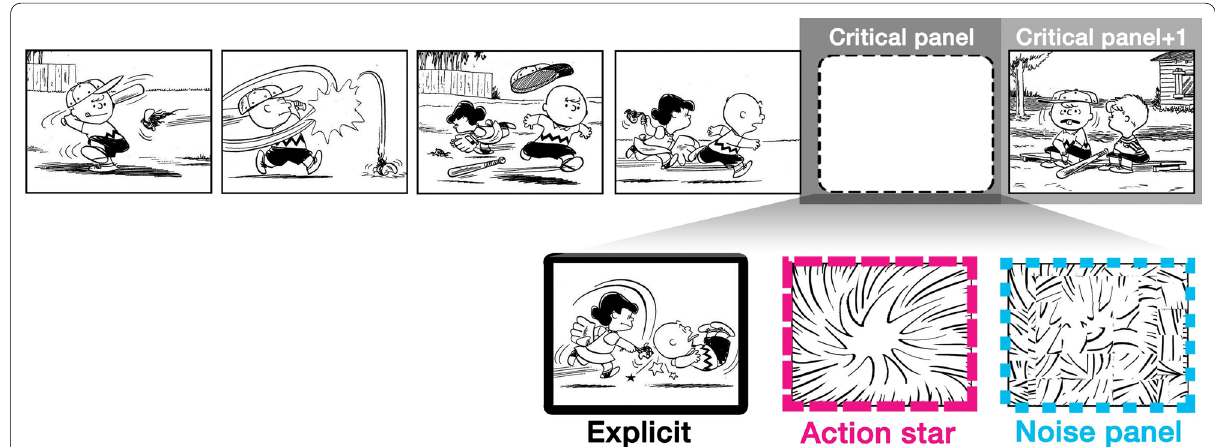
Fig. 2 Example stimuli for visual narrative sequences with a critical panel of either an explicit event, a conventionalized action star, or a noise panel. Peanuts is © Peanuts Worldwide